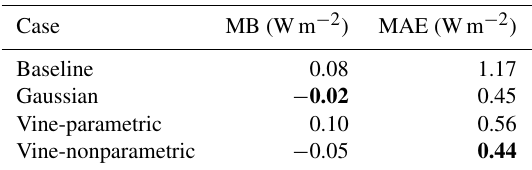
and by up to 62 % for the mean absolute error (from 1.17 to 0.44 W m − 2 ; Table